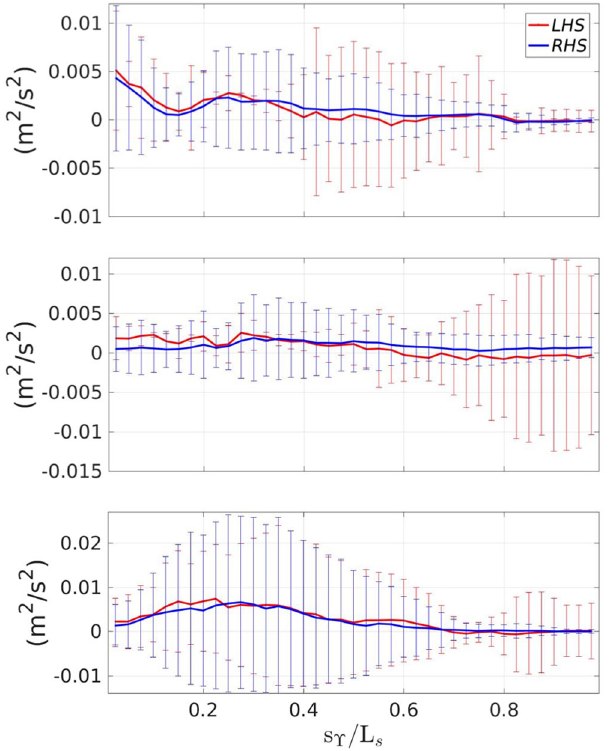
Figure 3. Balance between the left and right-hand side of equation 1 along the breaker. From top to bottom: ⁎ t ⁎ t , ⁎ t t e